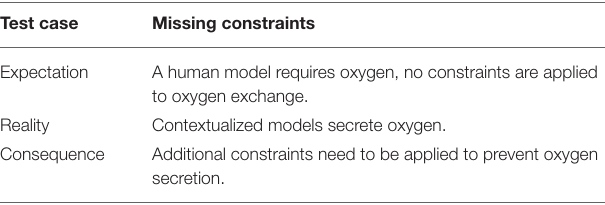
TABLE 2 | Test case illustrating possible loophole in the reaction constraints. Test